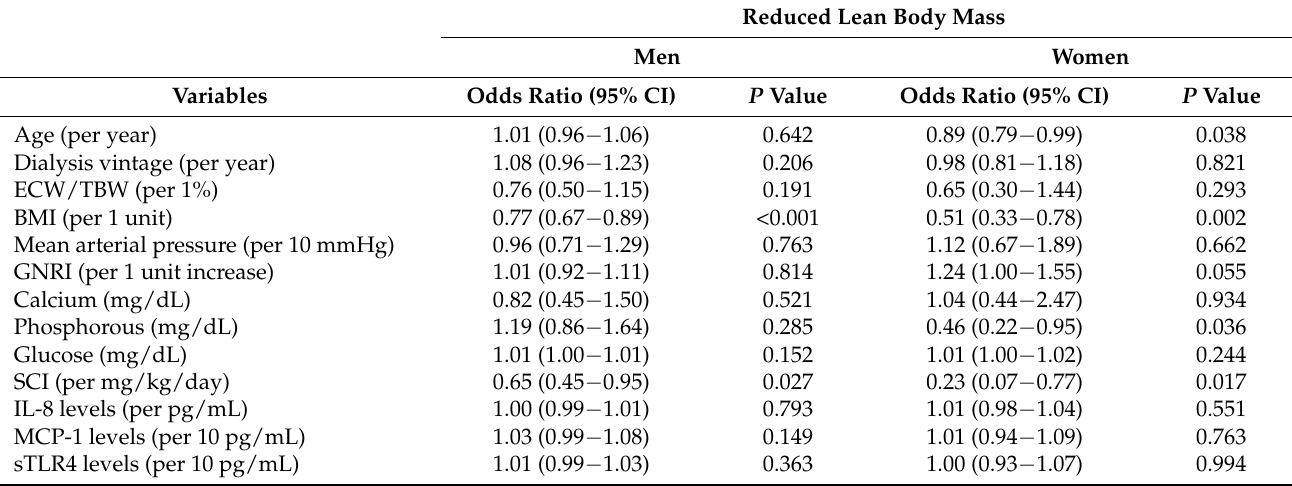
Table 4. Multivariate logistic regression analysis of factors associated with reduced lean body mass in male and female hemodialysis patients a .